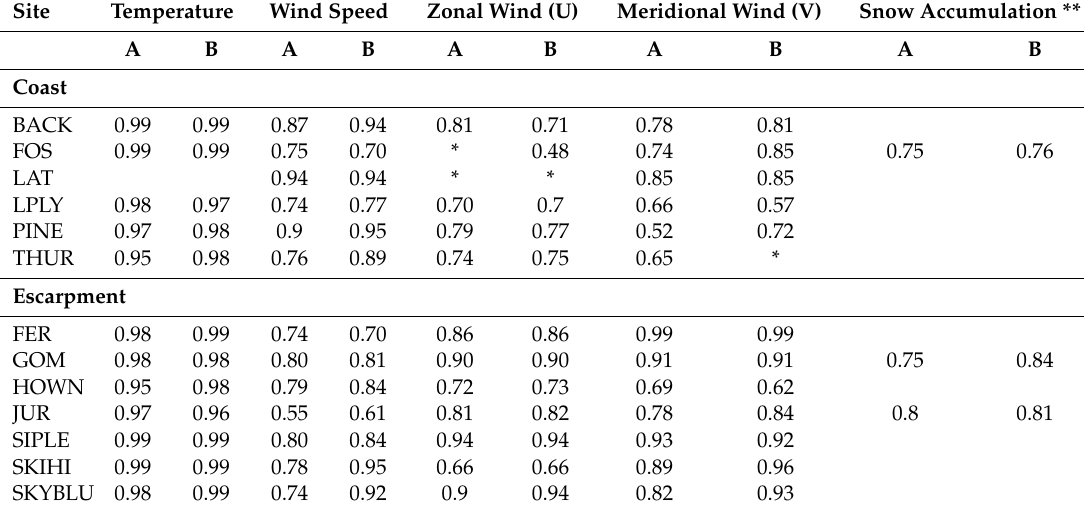
Table 4. Pearson’s linear correlation coe ffi cient between monthly meteorological parameters and ERA-Interim reanalysis (A), and between monthly meteorological parameters and ERA5 reanalysis (B). All data presented are statistically significant ( p <